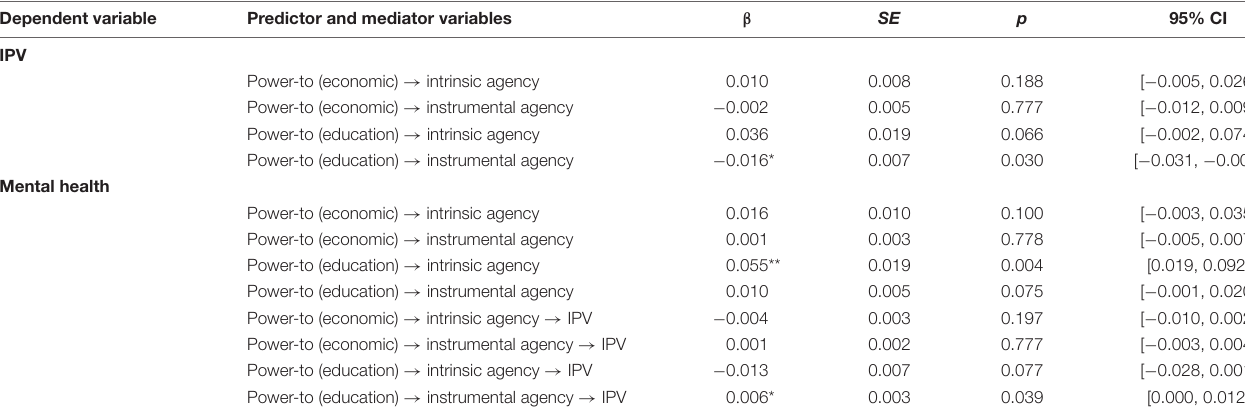
FIGURE 2 | Standardized regression coefficients of an exploratory full model of the mediating role of intrinsic and instrumental agency between the power to variables and IPV. *** p < 0.001, ** p < 0.01; solid indicate statistically significant coefficients and dotted gray lines indicate non-statistically significant coefficients. + p < 0.10. TABLE 2 | Standardized indirect effects of Power to (education and economic) on IPV and mental health through the agency (personal and instrumental) variables. Dependent